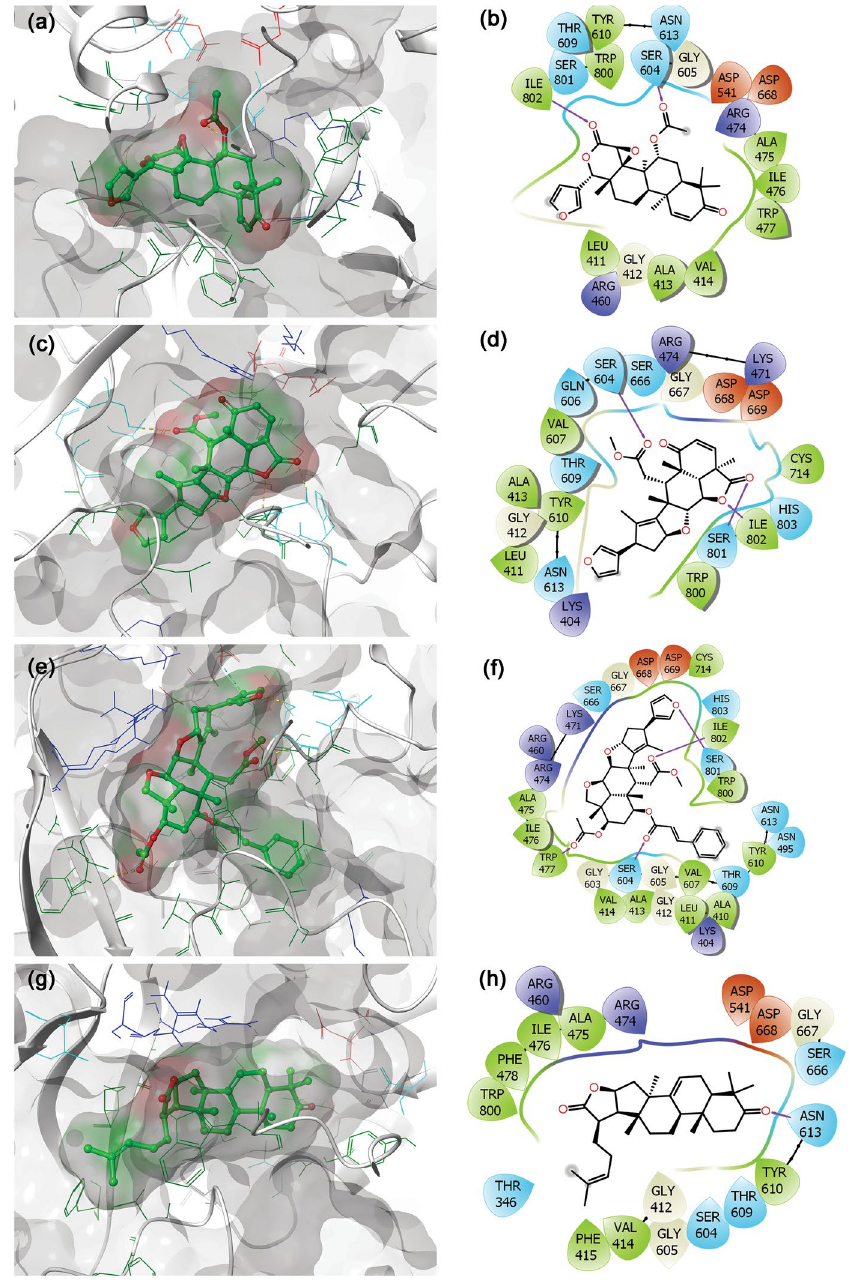
Figure 3. 3D and 2D docked poses of the selective bioflavonoids, i.e., ( a , b ) Gedunin, ( c , d ) Nimbolide, ( e , f ) Ohchinin acetate, and ( g , h ) Kulactone, collected at 4 Å space around the ligand within in the active site of jRdRP protein. In 3D structures, protein surface and ligand surface were rendered based on the alpha-carbon and atomic charge, respectively. While in 2D maps, hydrogen bond formation (pink arrows), hydrophobic (green), polar (blue), red (negative), violet (positive), glycine (grey) interactions are logged for docked complexes of jRdRp with selected bioactive